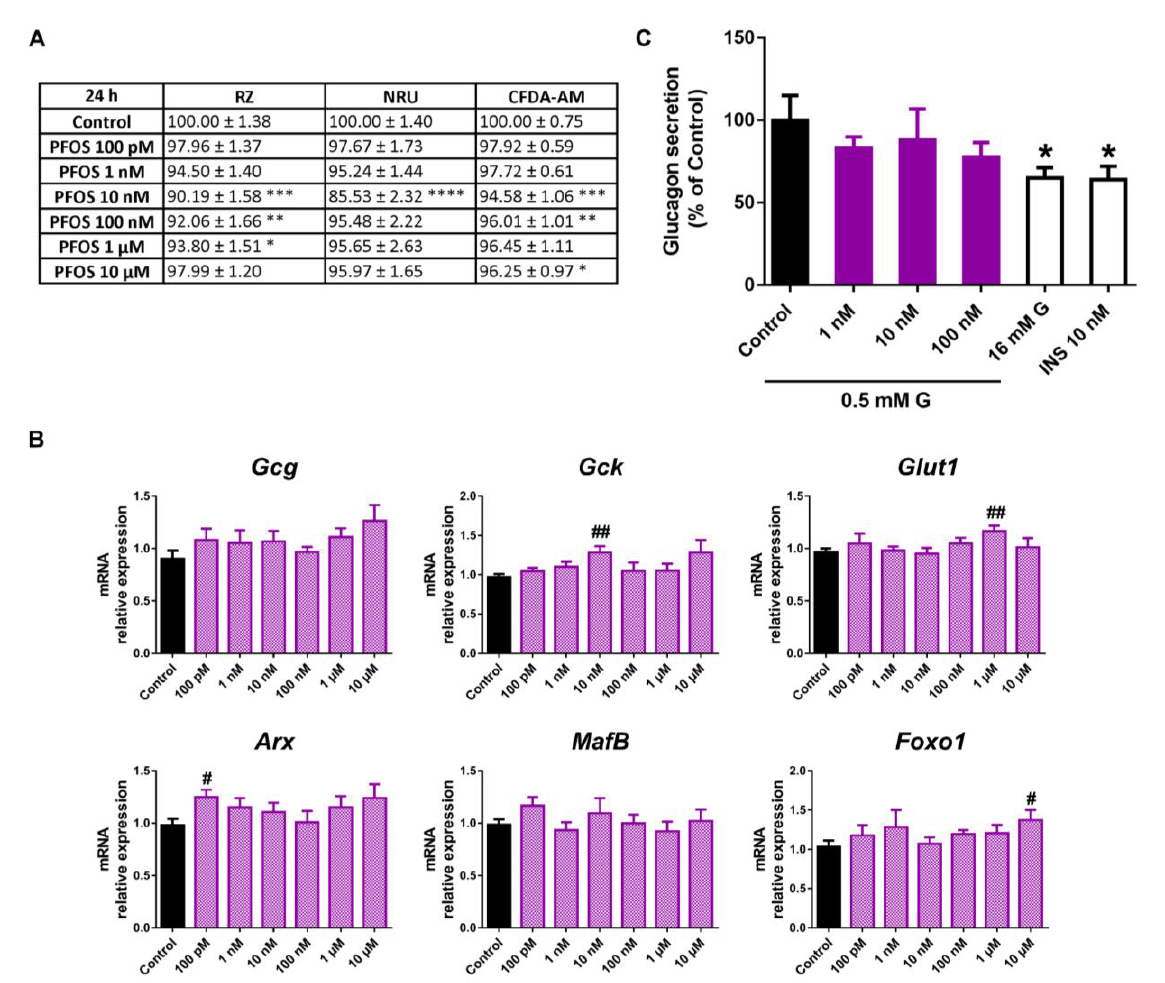
Figure 7. PFOS effects on pancreatic α -cells. ( A ) Viability of pancreatic α TC1-9 cells treated for 24 h with different concentrations of PFOS (100 pM–10 µ M), as evaluated by RZ, NRU, and CFDA-AM assays. Results are expressed as % of the solvent controls (Control = 100%). ( B ) mRNA expression of Gcg , Gck , Glut1 , Arx , MafB , and Foxo1 in control- and PFOS-treated α TC1-9 cells for 24 h. ( C ) Glucagon secretion in α TC1-9 cells treated for 24 h with PFOS. Data are represented as mean ± SEM of ( A ) n = 3, ( B ) n = 3, and ( C ) n = 3 independent experiments. * vs. Control; * p < 0.05, ** p < 0.01, *** p < 0.001, **** p < 0.0001 by one-way ANOVA followed by Dunnett’s post hoc test or Kruskal–Wallis followed by Dunn’s